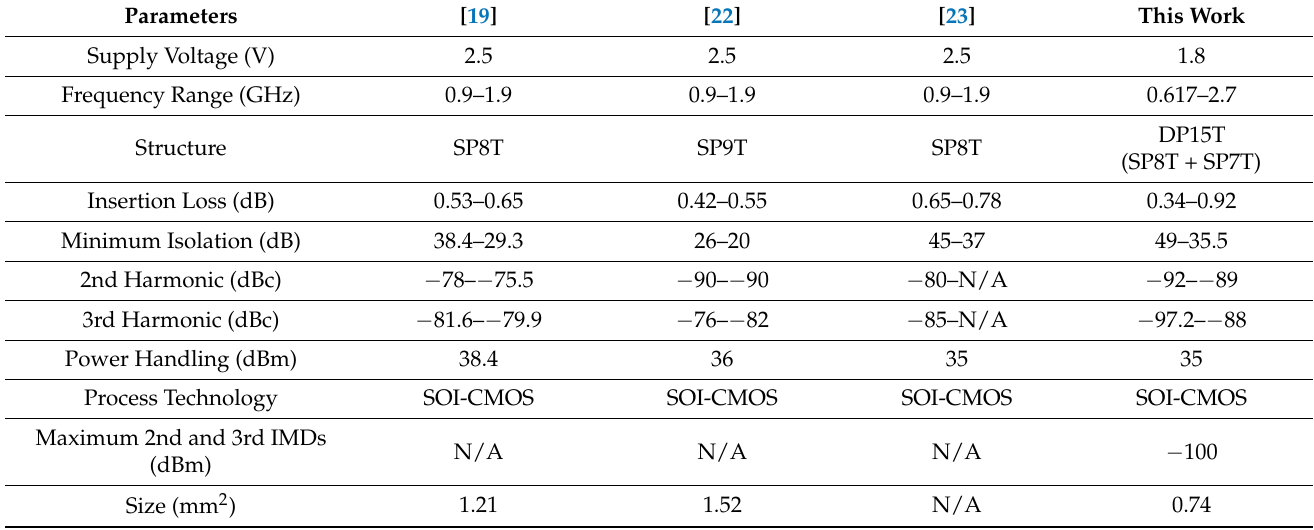
Table 1. Comparison table for various TIA